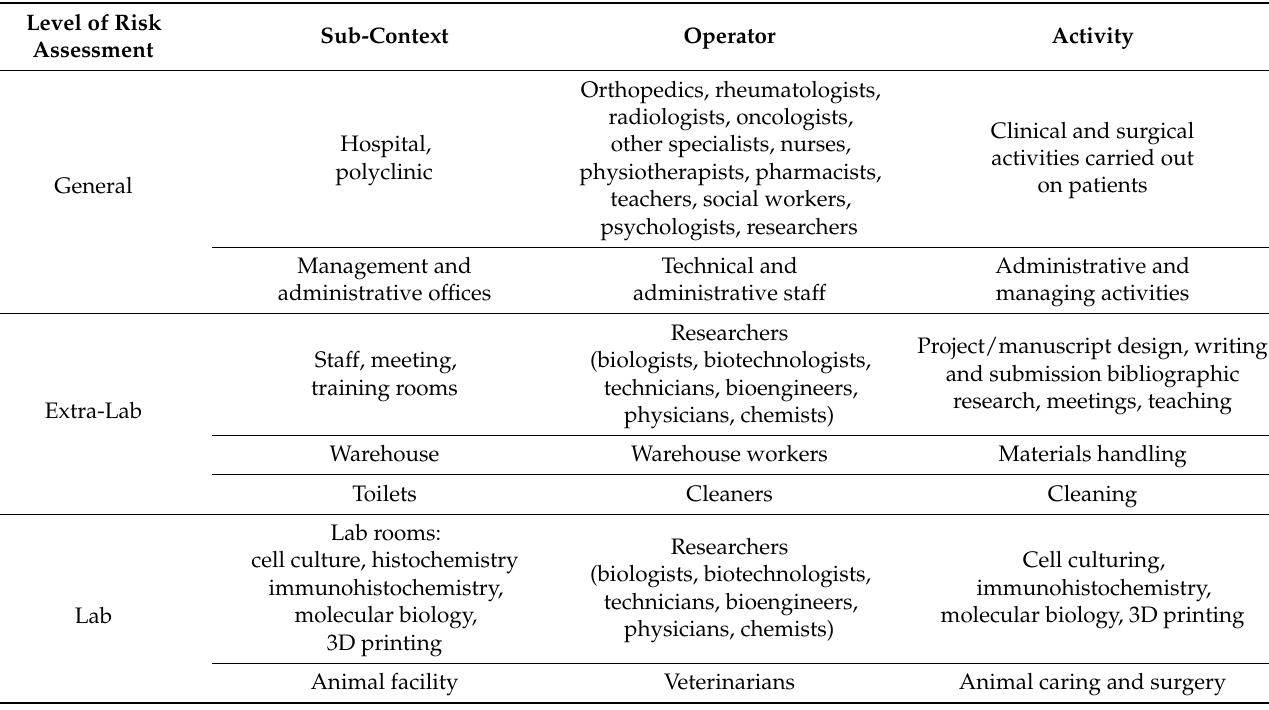
Table 2. Levels of risks assessment to consider for sub-context, operator, and activity.